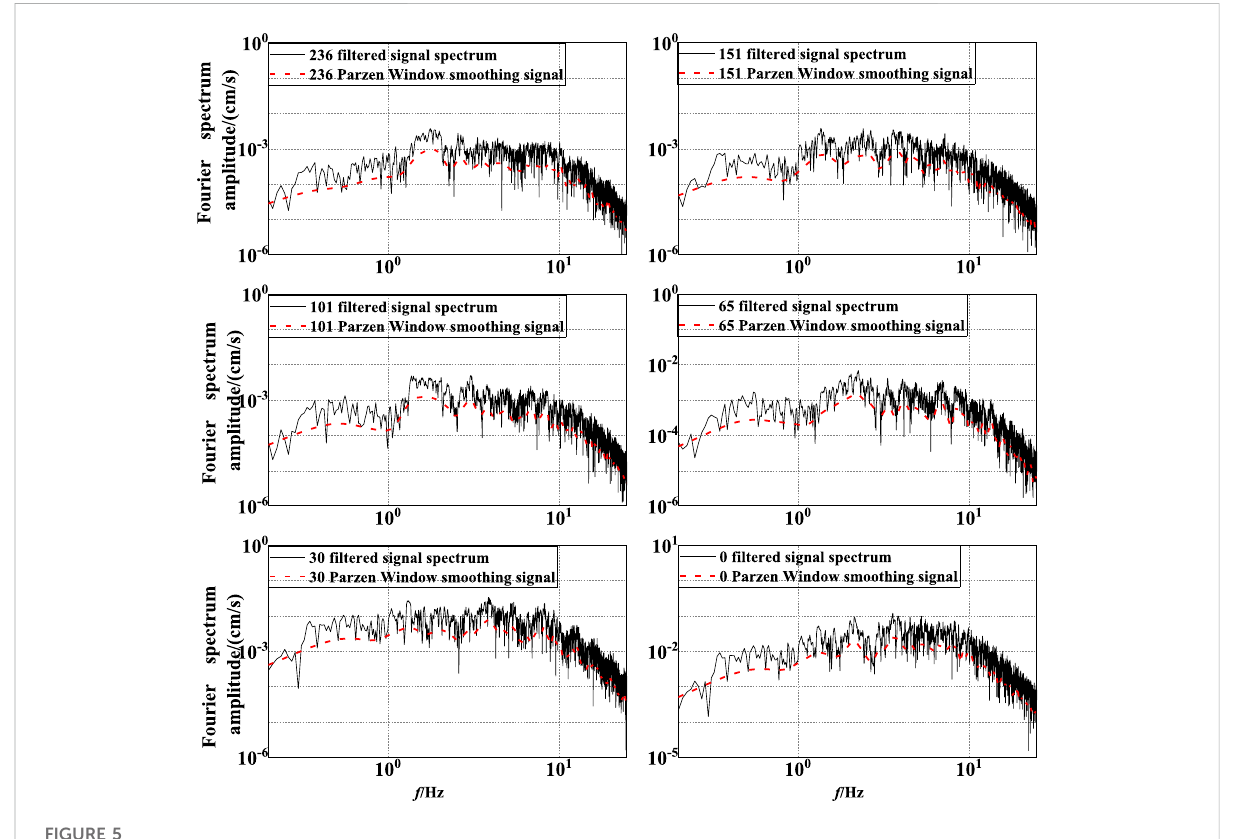
FIGURE 5 Guye strong motion record smoothing effects (east – west